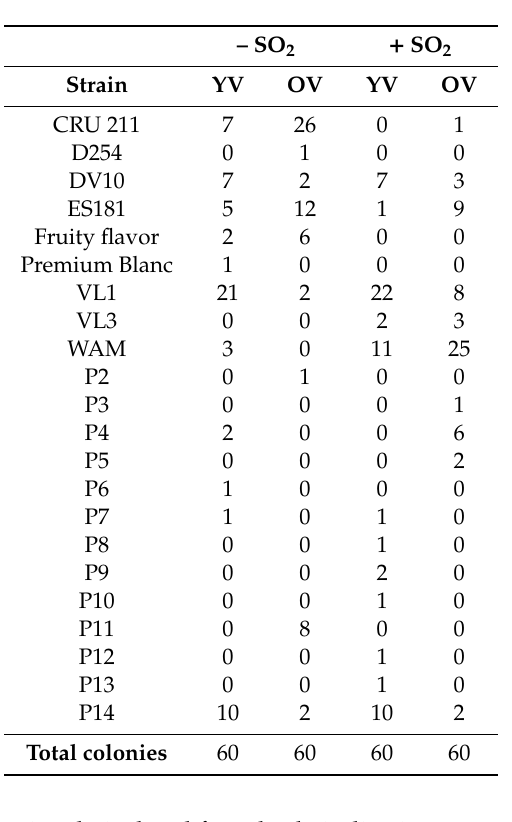
Table 3. S. cerevisiae strains isolated at 6% ethanol during spontaneous fermentations of grapes harvested at sampling time H3. – SO 2 : fermentation without SO 2 addition; + SO 2 : fermentation with addition of 50 mg / L of